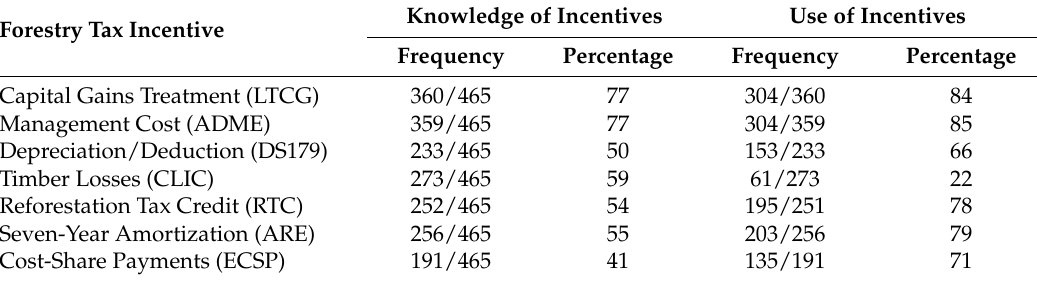
Table 3. Awareness and use (by those aware) of forestry tax incentives